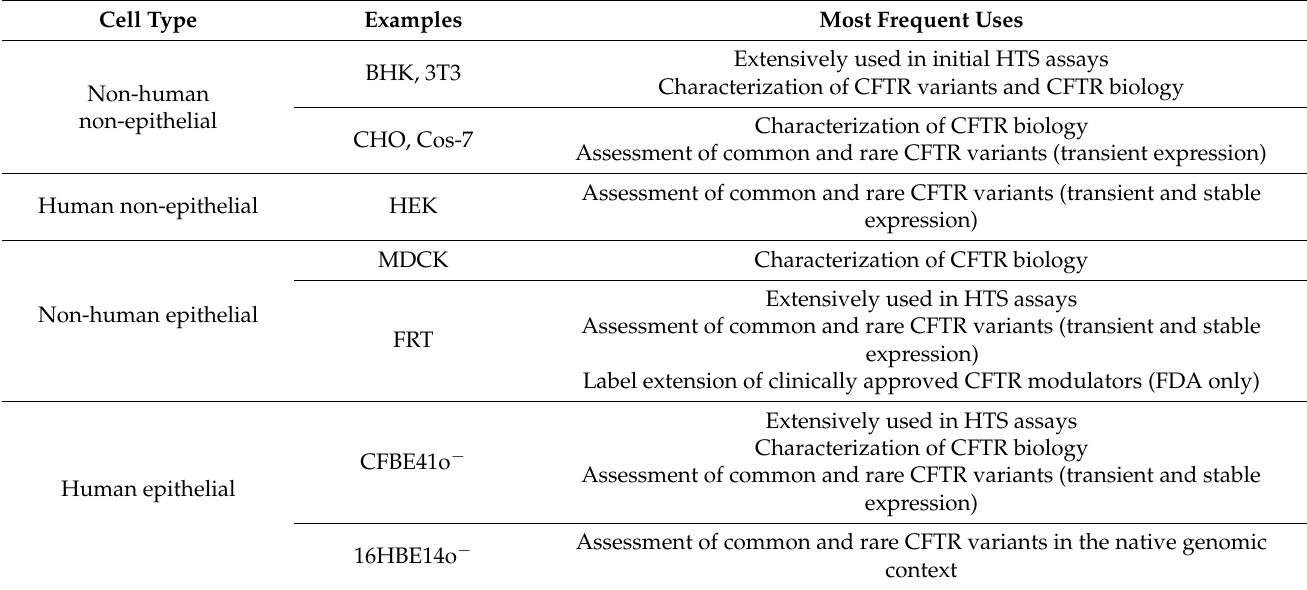
Table 1. Cell lines commonly used in CF